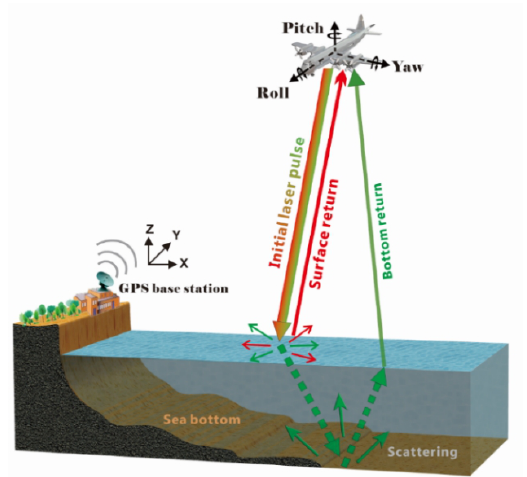
Figure 1. Dual LIDAR radar working